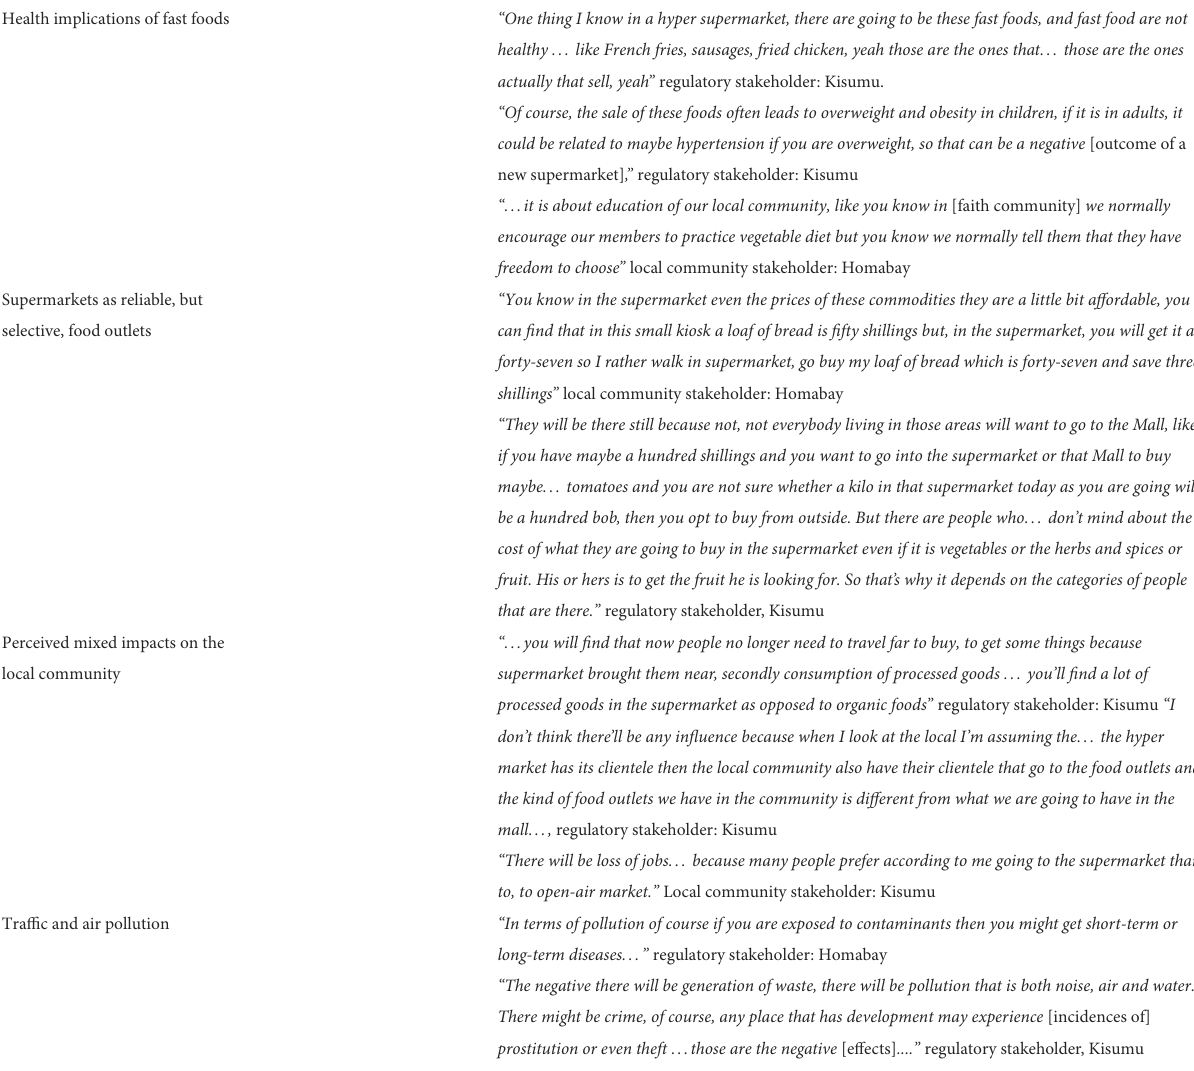
TABLE 1 Summary of main